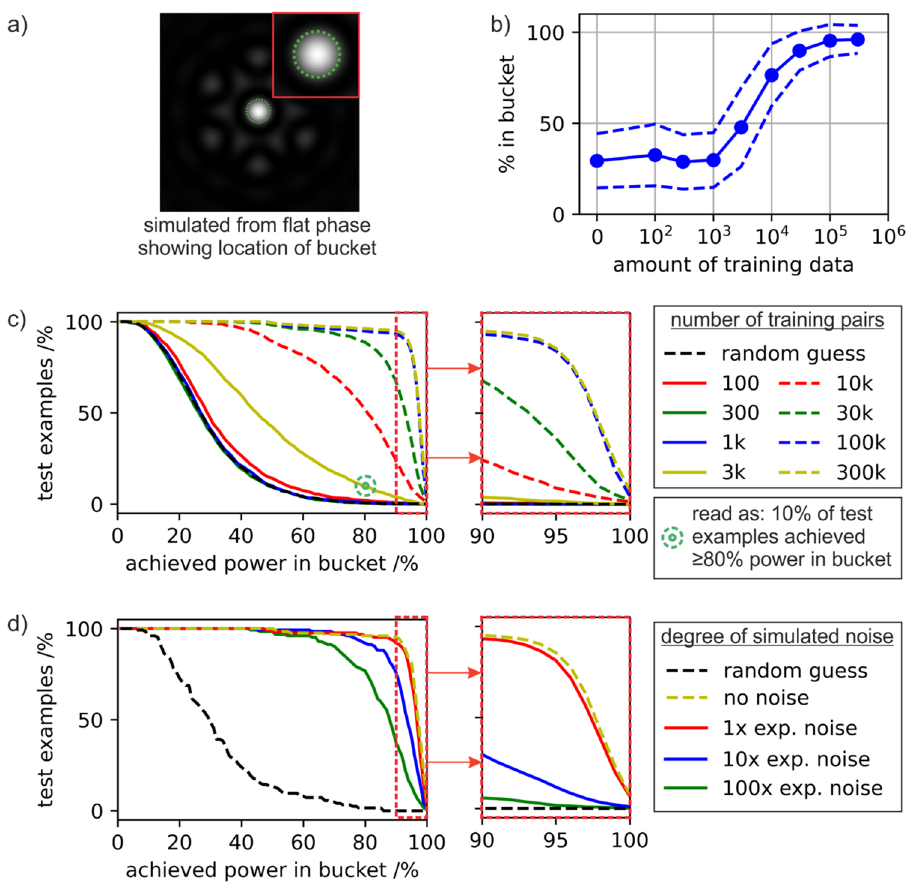
Figure 4. Analysis of errors for 1500 randomly chosen test examples showing ( a ) concept of power in the bucket, corresponding here to the percentage of intensity in the bucket for the corrected intensity profile divided by the percentage in the bucket for the flat phase case, ( b ) the mean and standard deviation of power in the bucket for different numbers of training data pairs, ( c ) distribution of test examples vs achieved power in the bucket for different amounts of training data and ( d ) distribution of test examples vs achieved power in the bucket for different levels of simulated noise for the 300 k case. Note that the line associated with the random guess is the same in both ( c ) and ( d